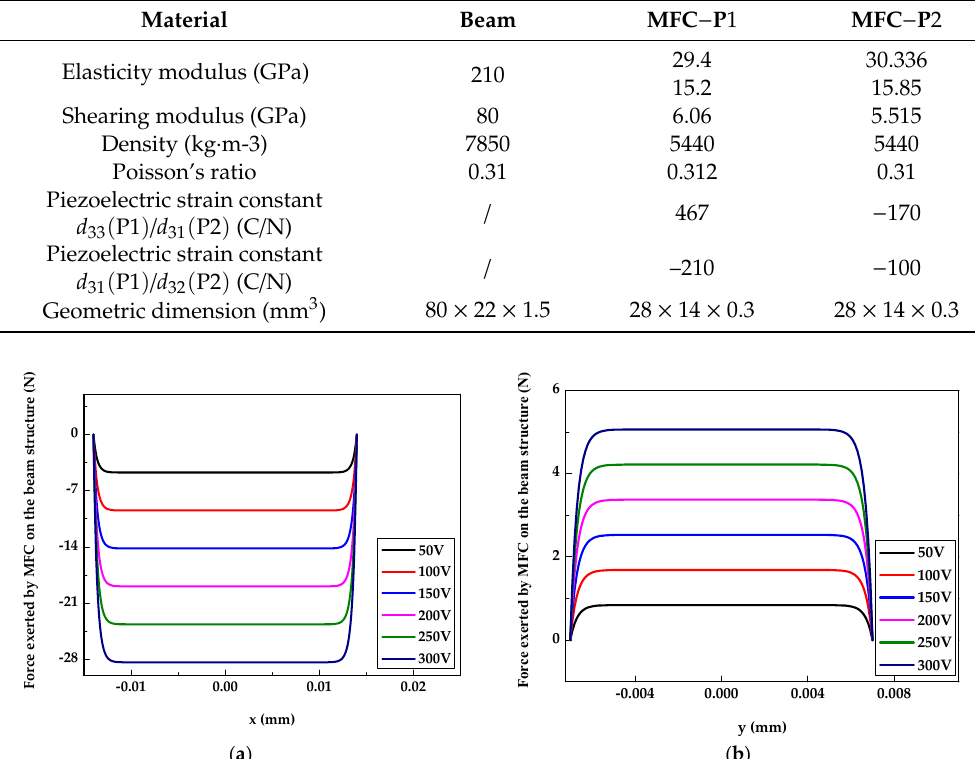
Figure 6. Model of the MFC laminated beam structure. Table 1. Parameters of the beam structure and MFC [29].